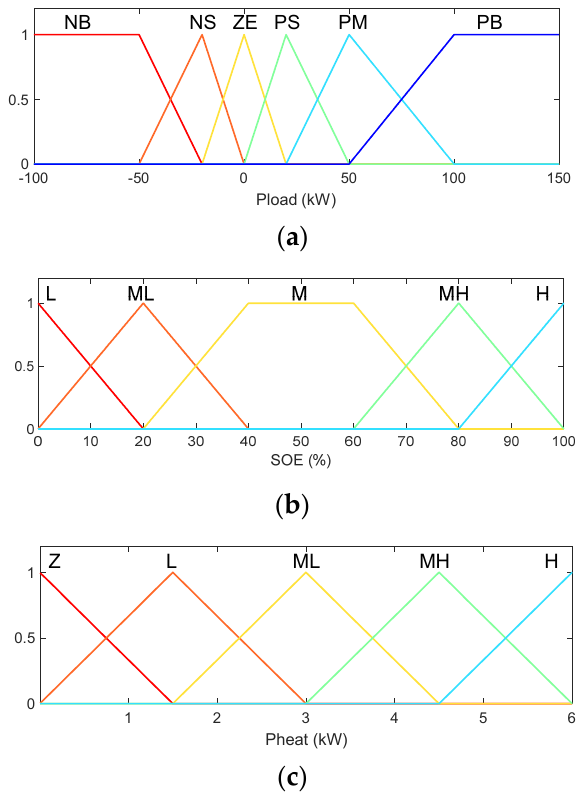
Figure 8. Membership functions of input and output variables. ( a ) Input variable ( P load ); ( b ) input variable ( SOE ); ( c ) output variable ( P heat ). Table 3. Fuzzy rule for the low temperature